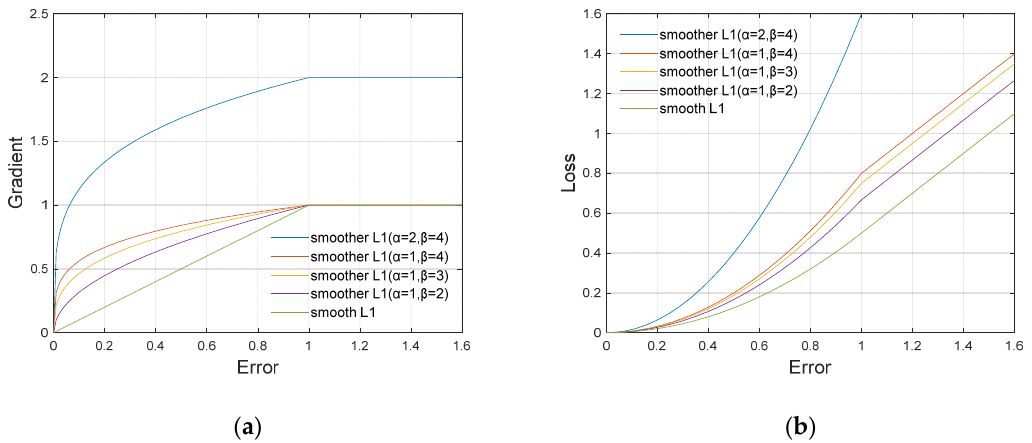
Figure 6. The curves of the smoother L1 with different 𝛼 and 𝛽 . We set 𝛼 to control the gradient of outliers, and 𝛽 to control the changing trend of the gradient of inliers. ( a ) The gradient curve of the smoother L1. ( b ) The loss curve of the smoother L1.